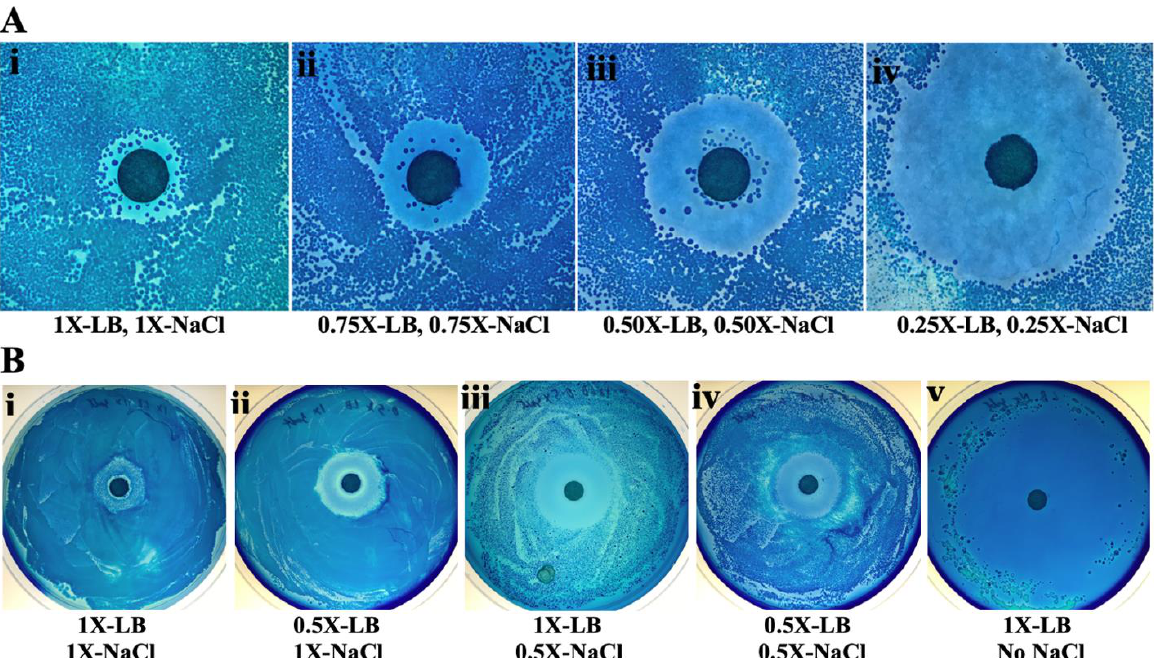
Figure 2. Effect of salt and nutrient concentration on the zone of inhibition. Disk diffusion assays with 10 −3 mL of an overnight culture of E. coli (MV10) cells spread on each plate. ( A ) Nutrient and salt concentrations were varied proportionately as indicated below each image, (i – iv). ( B ) Nutrient and salt concentrations were varied independently as indicated below each image, (i – v). Each disk in ( A ) had 15 μL and in ( B ) had 10 μL of a 9× concentrated crude aqueous extract of rhubarb stalk. All plates were incubated for 1 day, except B (v), which was incubated for 2 days at 37 °C. The differences are explained in Section 2.3.